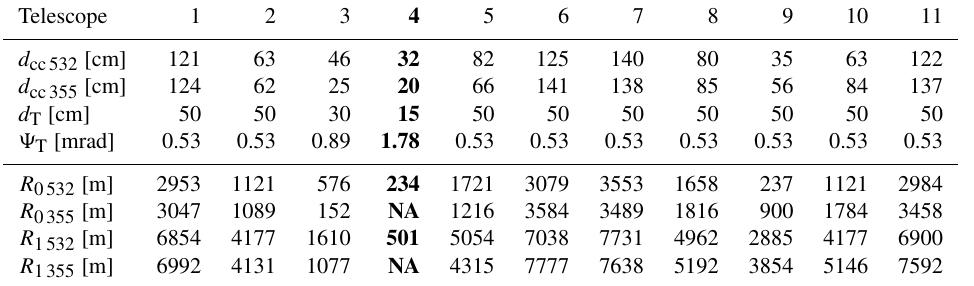
Table 5. Characteristics, initial ( R 0 ) and full ( R 1 ) overlap heights of the 11 telescopes for each emitted wavelength. Laser beam radius d L = 5 . 0cm and divergence (cid:57) L = 0 . 1mrad were used for the calculations. The specifications of interest for this study (channel 1: 532nm, 15cm telescope) are highlighted in bold. NA = not available.